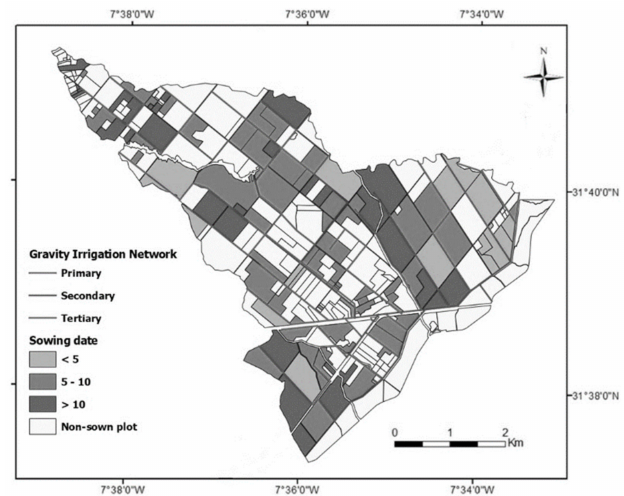
Figure 6. Optimal sowing date distribution simulated with the first sowing